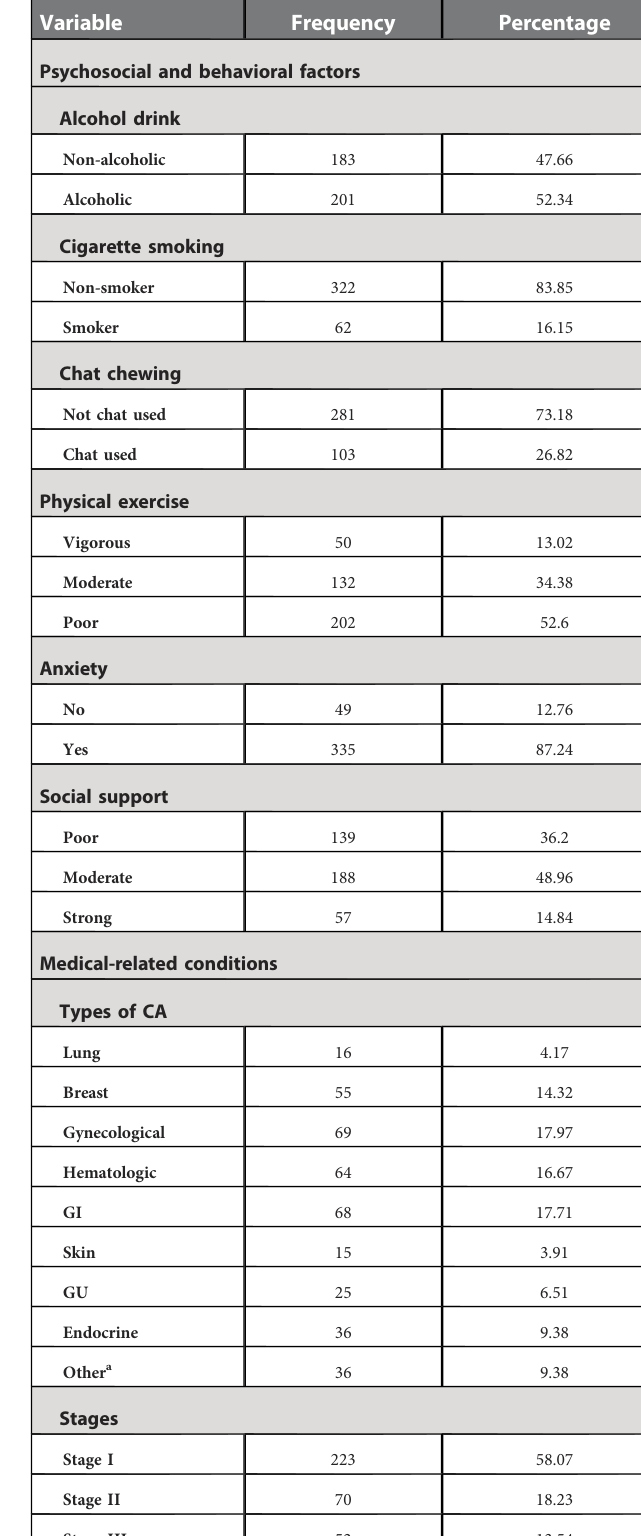
TABLE 1 Socio-demographic characteristics of adult cancer patients evaluated at oncology unit in UoGCSH, Northwest Ethiopia, 2,021 ( n =384). Variables